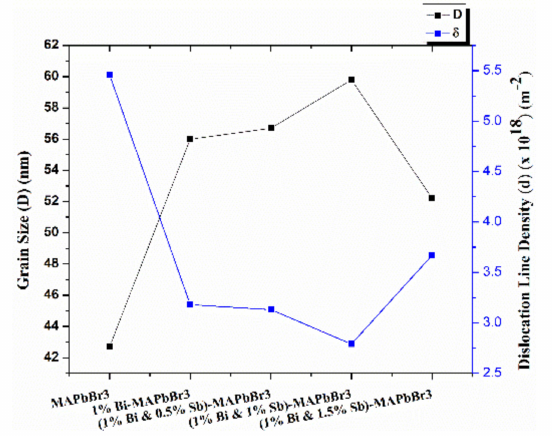
Figure 2. The D and δ variations for pure MAPbBr 3 and co-doped (1% Bi and 0.5%, 1% and 1.5% Sb)-MAPbBr 3 .